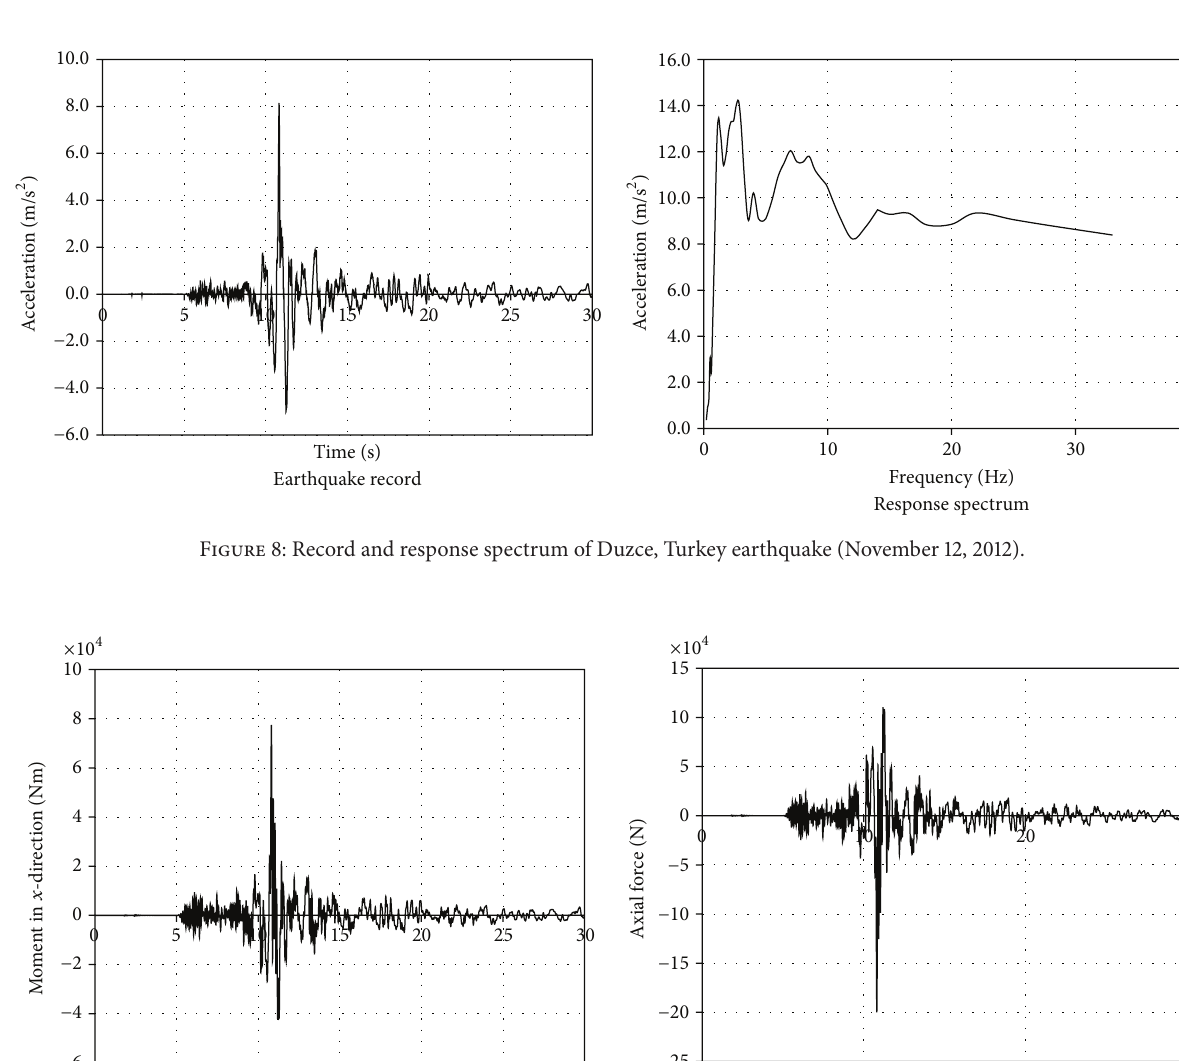
Figure 7: First and third mode shapes of the structure.